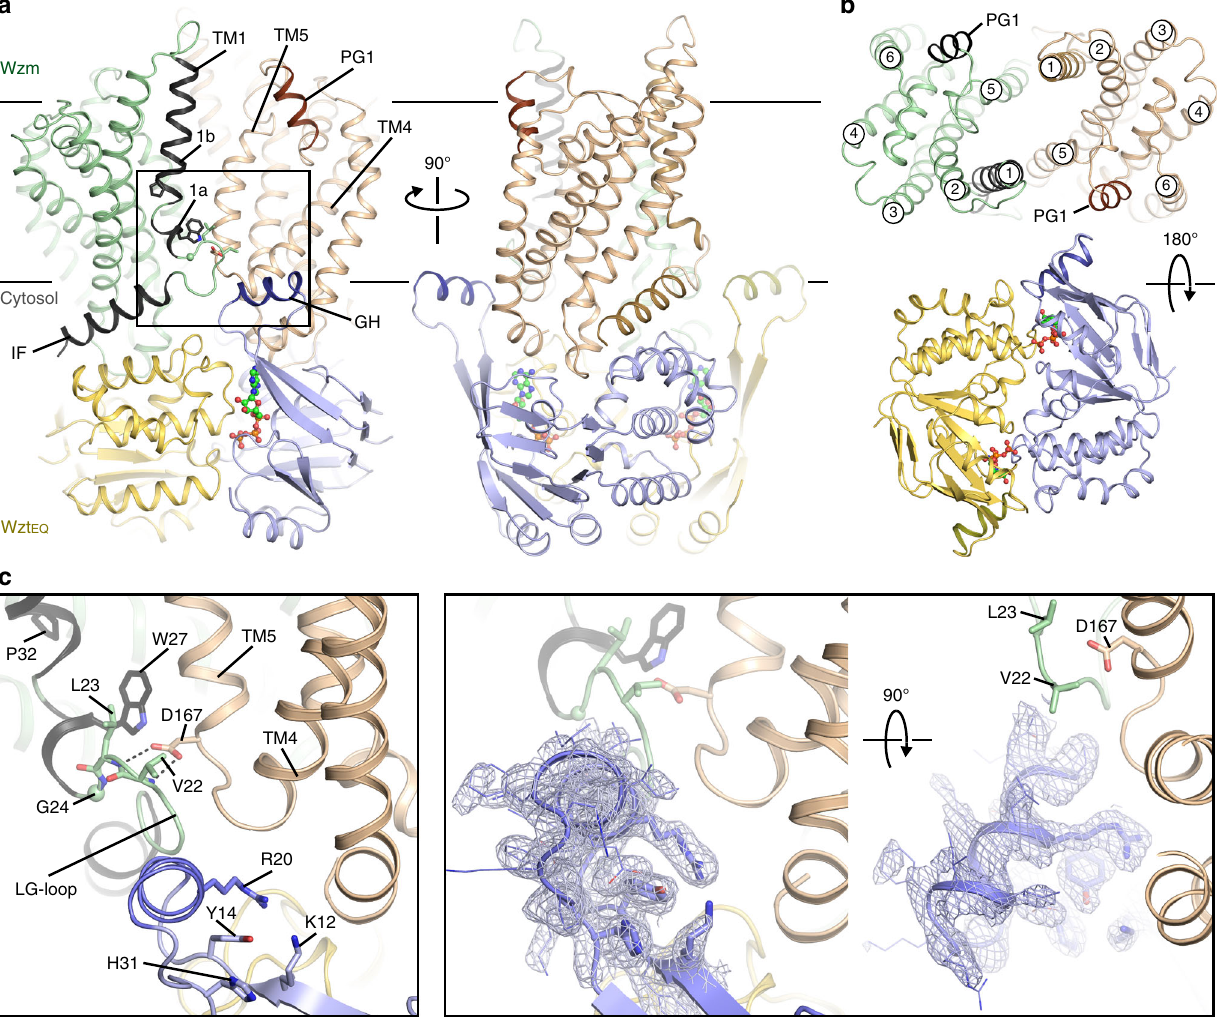
Fig. 1 ATP-bound structure of the O antigen ABC transporter. a Two orthogonal views of AaWzmWzt EQ with ATP bound. The Wzm protomers are shown in green and wheat with the N-terminal interface helix (IF) and TM helix 1 highlighted in black. The Wzt nucleotide-binding domains are shown in yellow and blue with bound ATP portrayed as ball-and-sticks. An extended loop of Wzt contains the cytoplasmic gate helix (GH, purple) that sits at the Wzm protomer interface. IF and TM1 are connected by the LG-loop. Lines show approximate lipid bilayer boundaries. b Periplasmic and cytosolic views of AaWzmWzt. Each Wzm protomer contains six transmembrane helices, and the loop between Wzm TM5/6 forms a short periplasmic gate helix (PG1). c The gate helix forms an electropositive pocket near the Wzm interface. Left: Interaction of the GH and LG-loop with the Wzm protomers. Right: Two orthogonal views of the GH with a 2Fo-Fc composite omit electron density map contoured at 1 σ shown as a gray